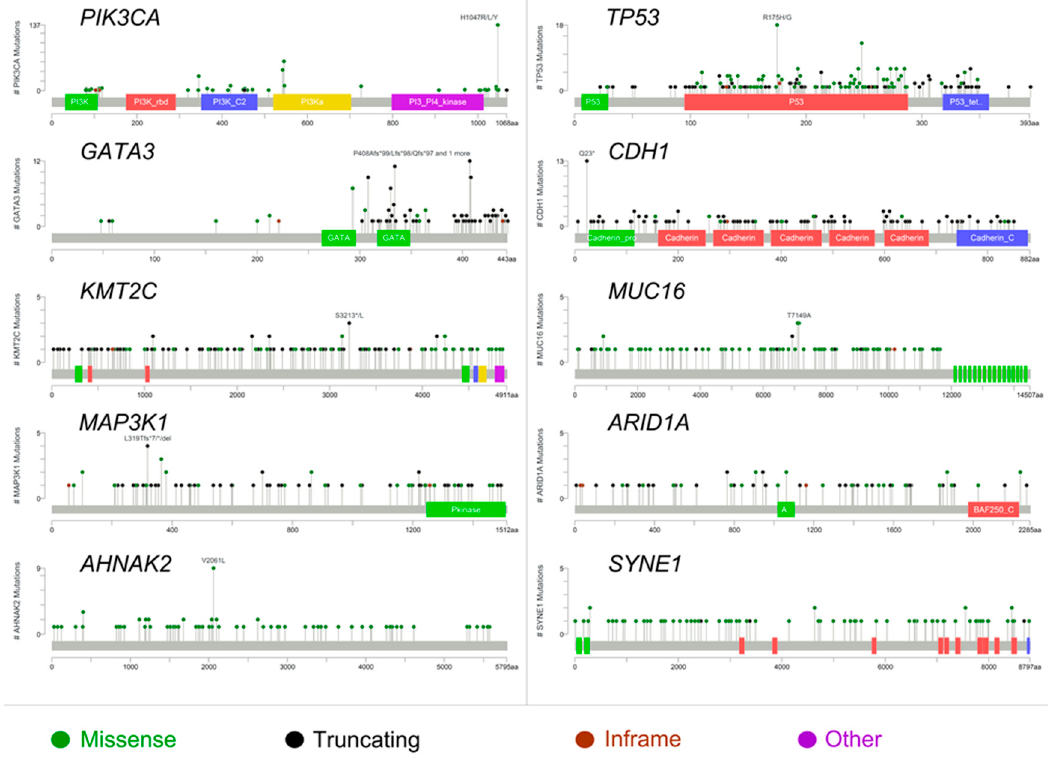
Figure 2. Type of mutations and affected protein domains of the 10 most frequently altered genes in ER+/PR − breast cancers. Mutation types are color-coded on the basis of the legend at the bottom.